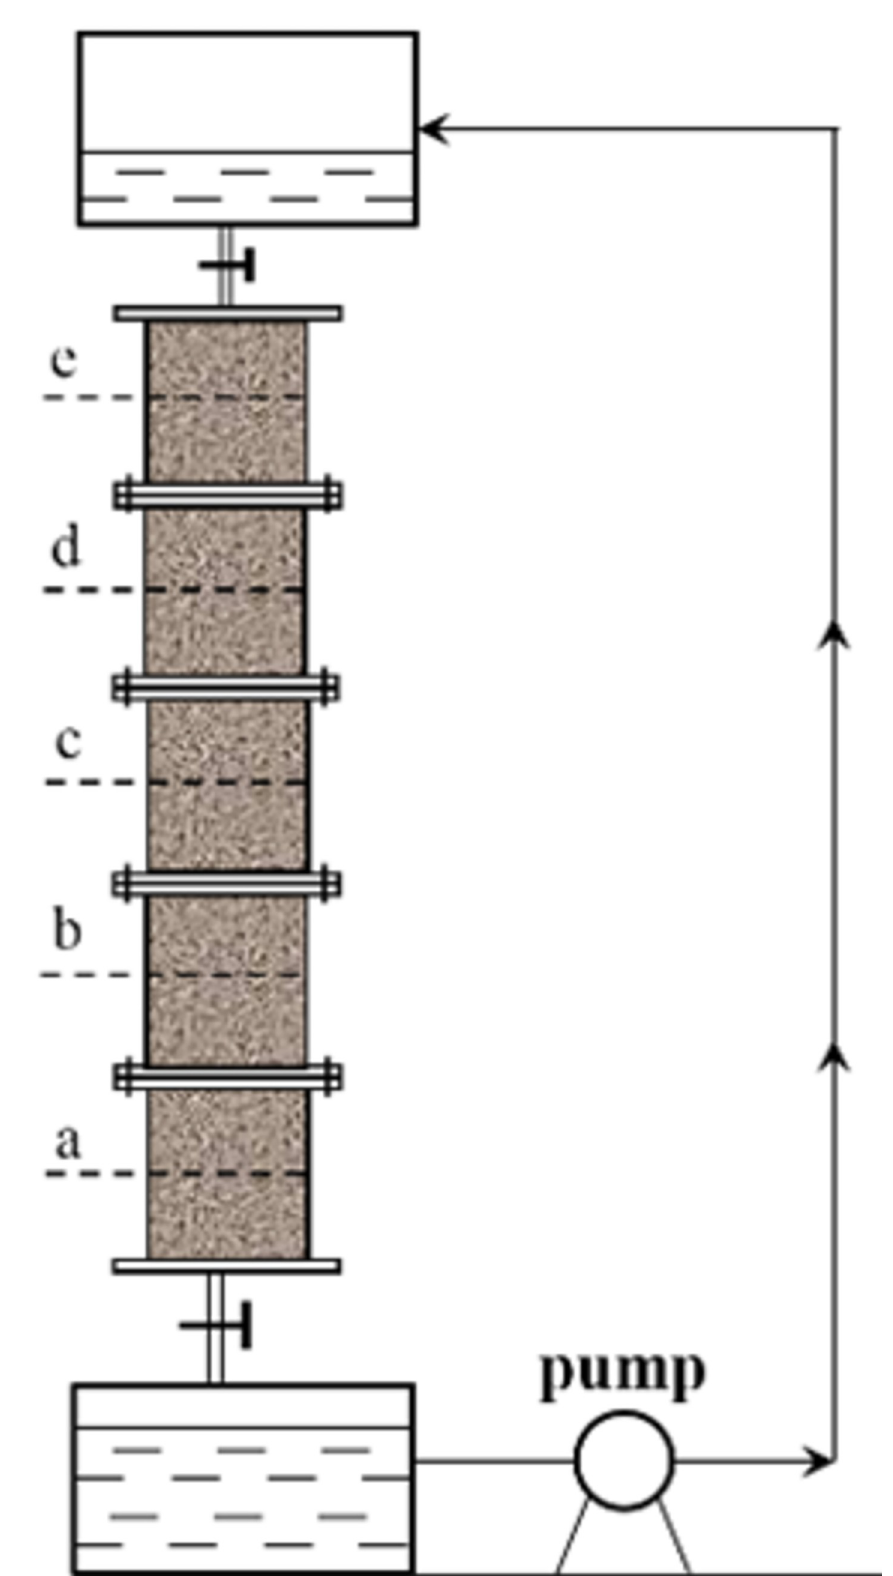
Fig 2. Schematic diagram of the test